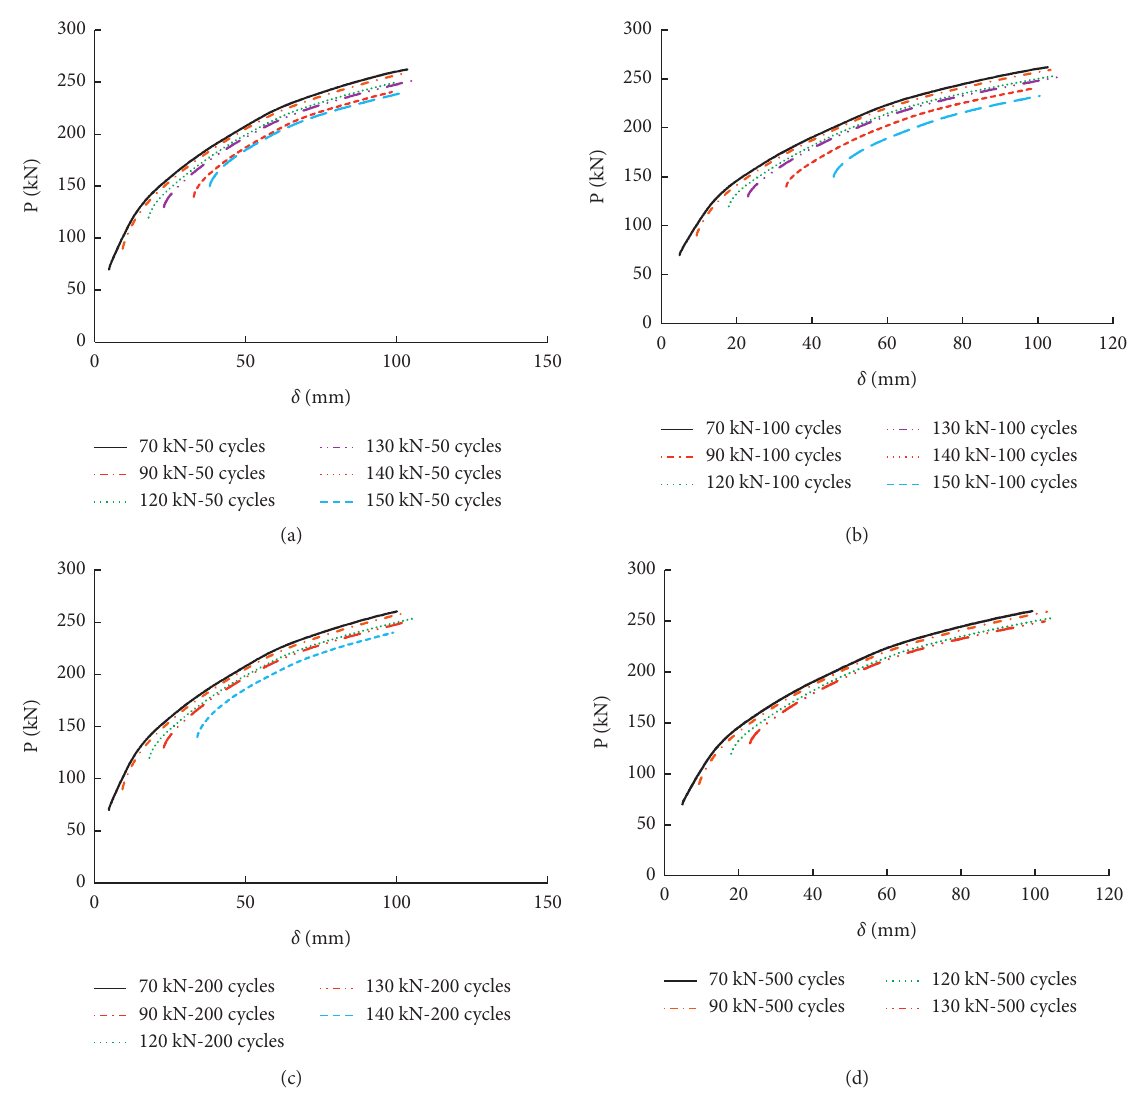
Figure 12: Load-deformation curves of different overload amplitude: (a) cycle numbers 50, (b) cycle numbers 100, (c) cycle numbers 200, and (d) cycle numbers